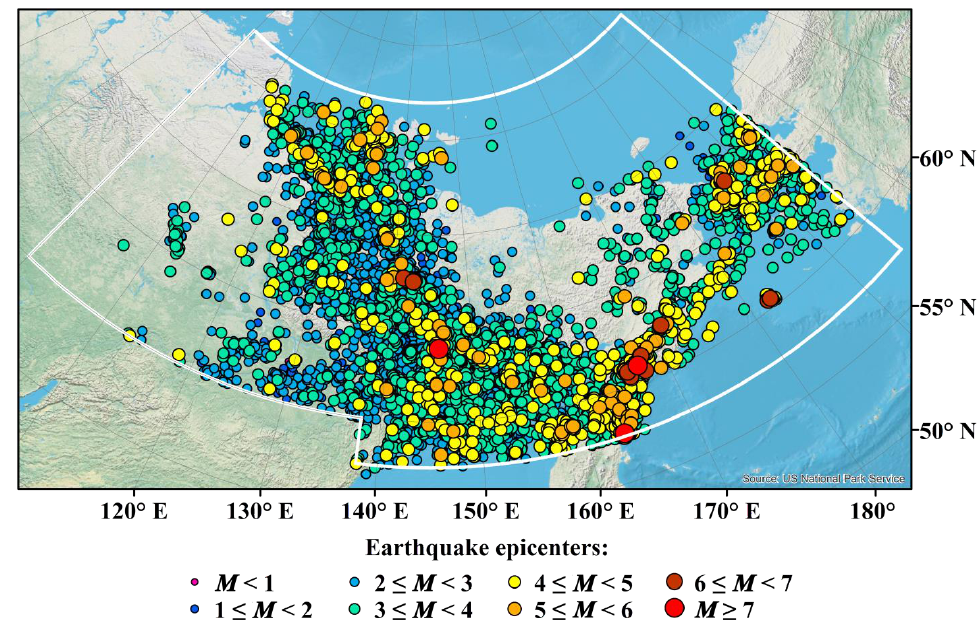
Figure 2. The integrated earthquake catalog of the Eastern Sector of the Arctic zone of the Russian Federation (1962 – 2020) [16]. The white frame shows the boundaries of the region (coincides with the region marked in Figure 1), for which the catalog was created and within which FCAZ recognition was performed.